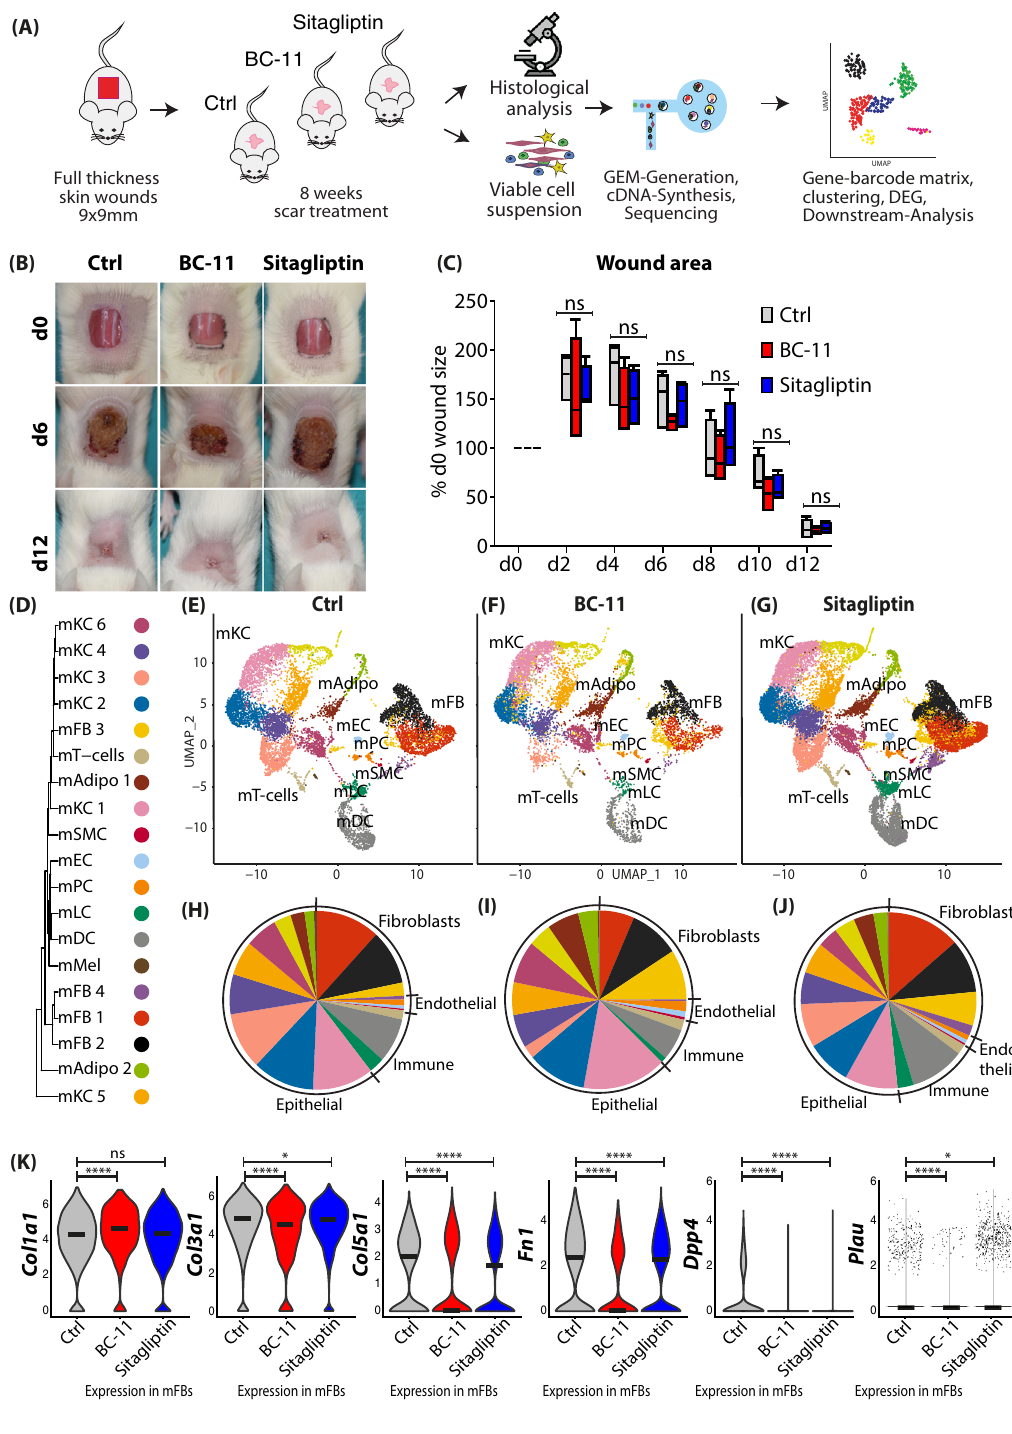
sera of secondary antibodies species, and Hoechst, for 1h at room temperature. Antibodies were used as indicated in Table S2. After the last wash, sections were mounted in aqueous mounting medium. Stainings were photographed using an Olympus BX63 microscope (Olympus, Tokyo, Japan) with Olympus CellSens Dimension v2.3 (Olympus) software with standardized exposure time for all samples. Staining intensity was quanti fi ed separately in dermis and epidermis using ImageJ v1.53c 79 . For dermal quanti fi cation, regions of interest (ROIs) of 70× 70 pixels were directly adjacent and parallel to the epidermis, contained no hair follicles or blood vessels, and were obtained from all regions of the specimen. For epidermal quanti fi cation, ROIs of 30× 30 pixels located within the epidermis from all regions of each specimen. The total corrected fl uorescence was measured by subtracting background values from area integrated density in the respective